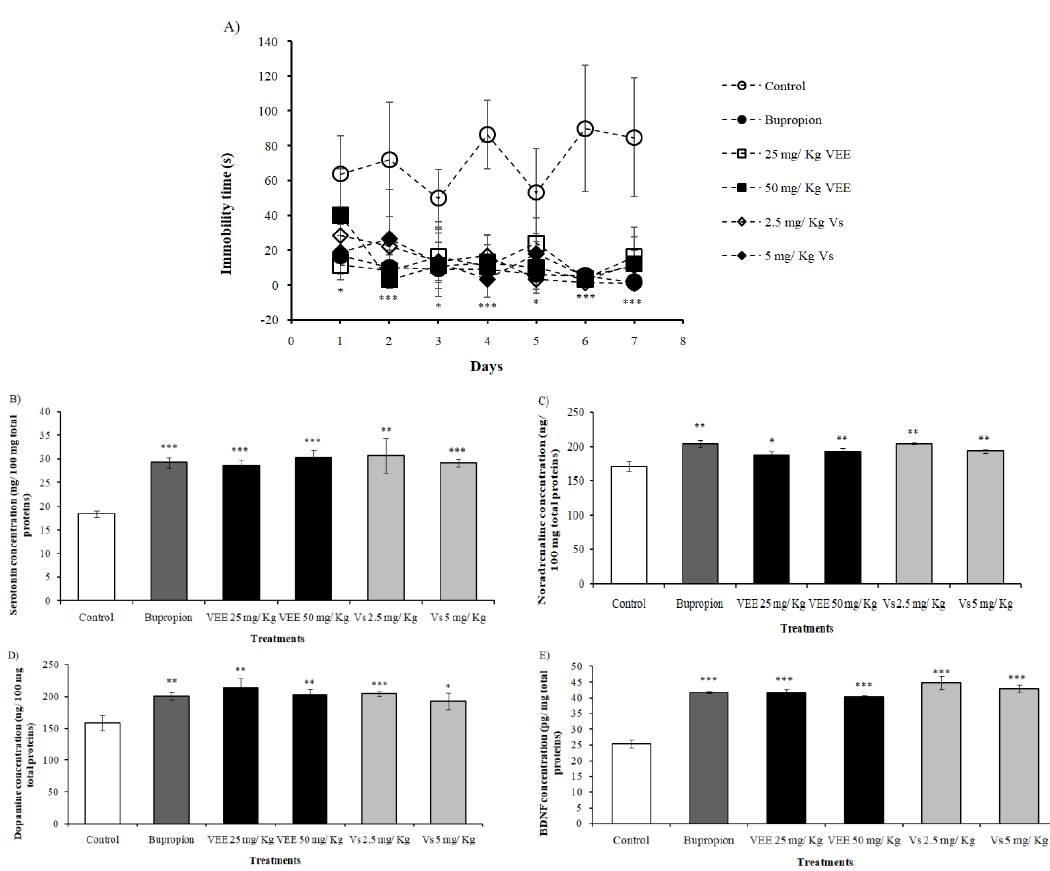
Figure 4. Effect of the oral administration of VEE (25 and 50 mg/Kg), Vs (2.5 and 5 mg/Kg) and bupropion (20 mg/Kg) on ( A ) mice immobility times in tail suspension test compared to the control (water 10 mL/Kg, p.o.) and their respective expression levels of ( B ) serotonin, ( C ) noradrenaline ( D ) dopamine and ( E ) BDNF. Results were expressed in mean of immobility time (s) and protein level ± SD. * P < 0.05; ** P < 0.001 and *** P < 0.0001 compared with Control group.